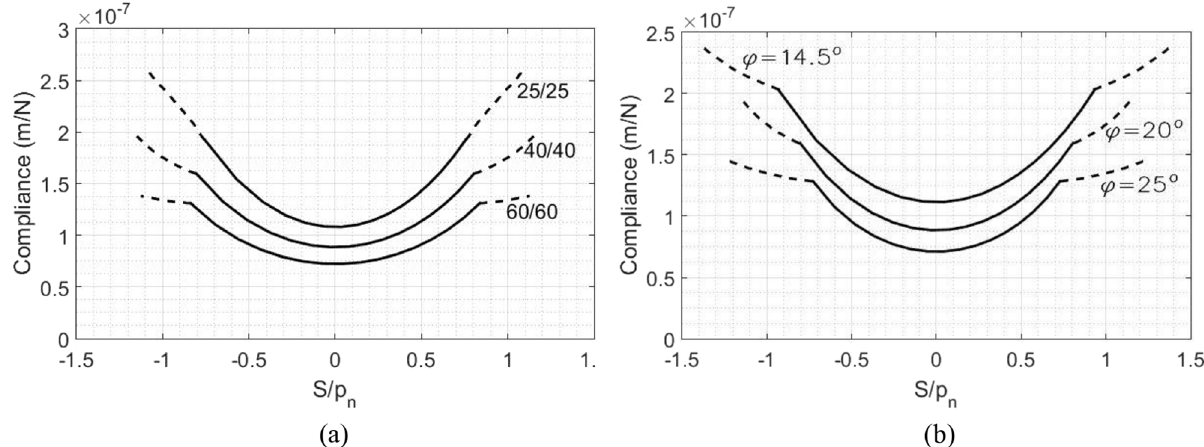
Fig. 4. Effects of increasing the number of teeth and the pressure angle on the compliance of plastic gear